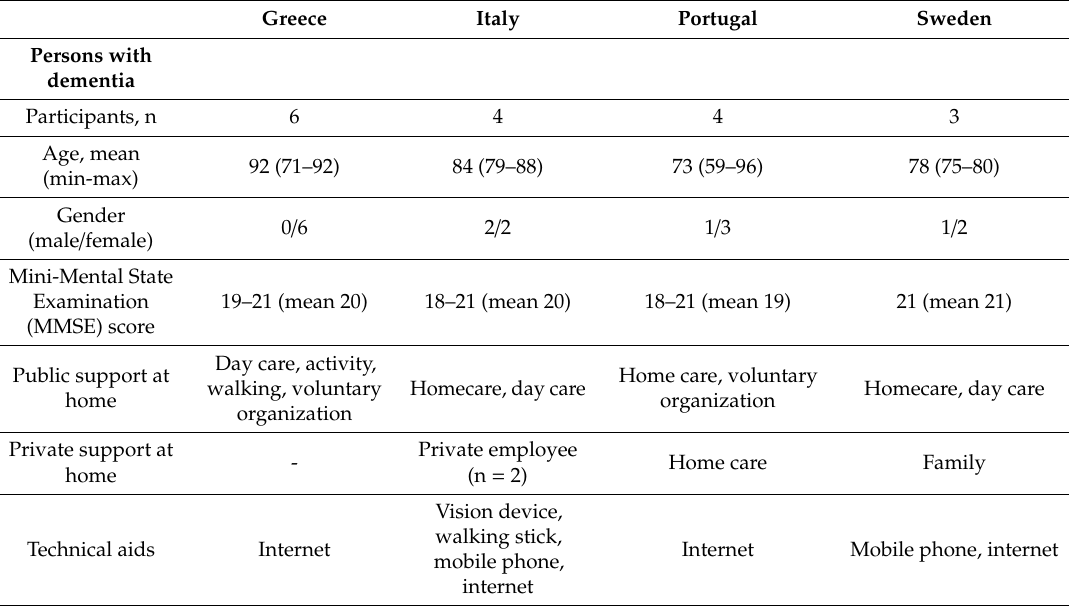
Table 1. Demographic characteristics of the